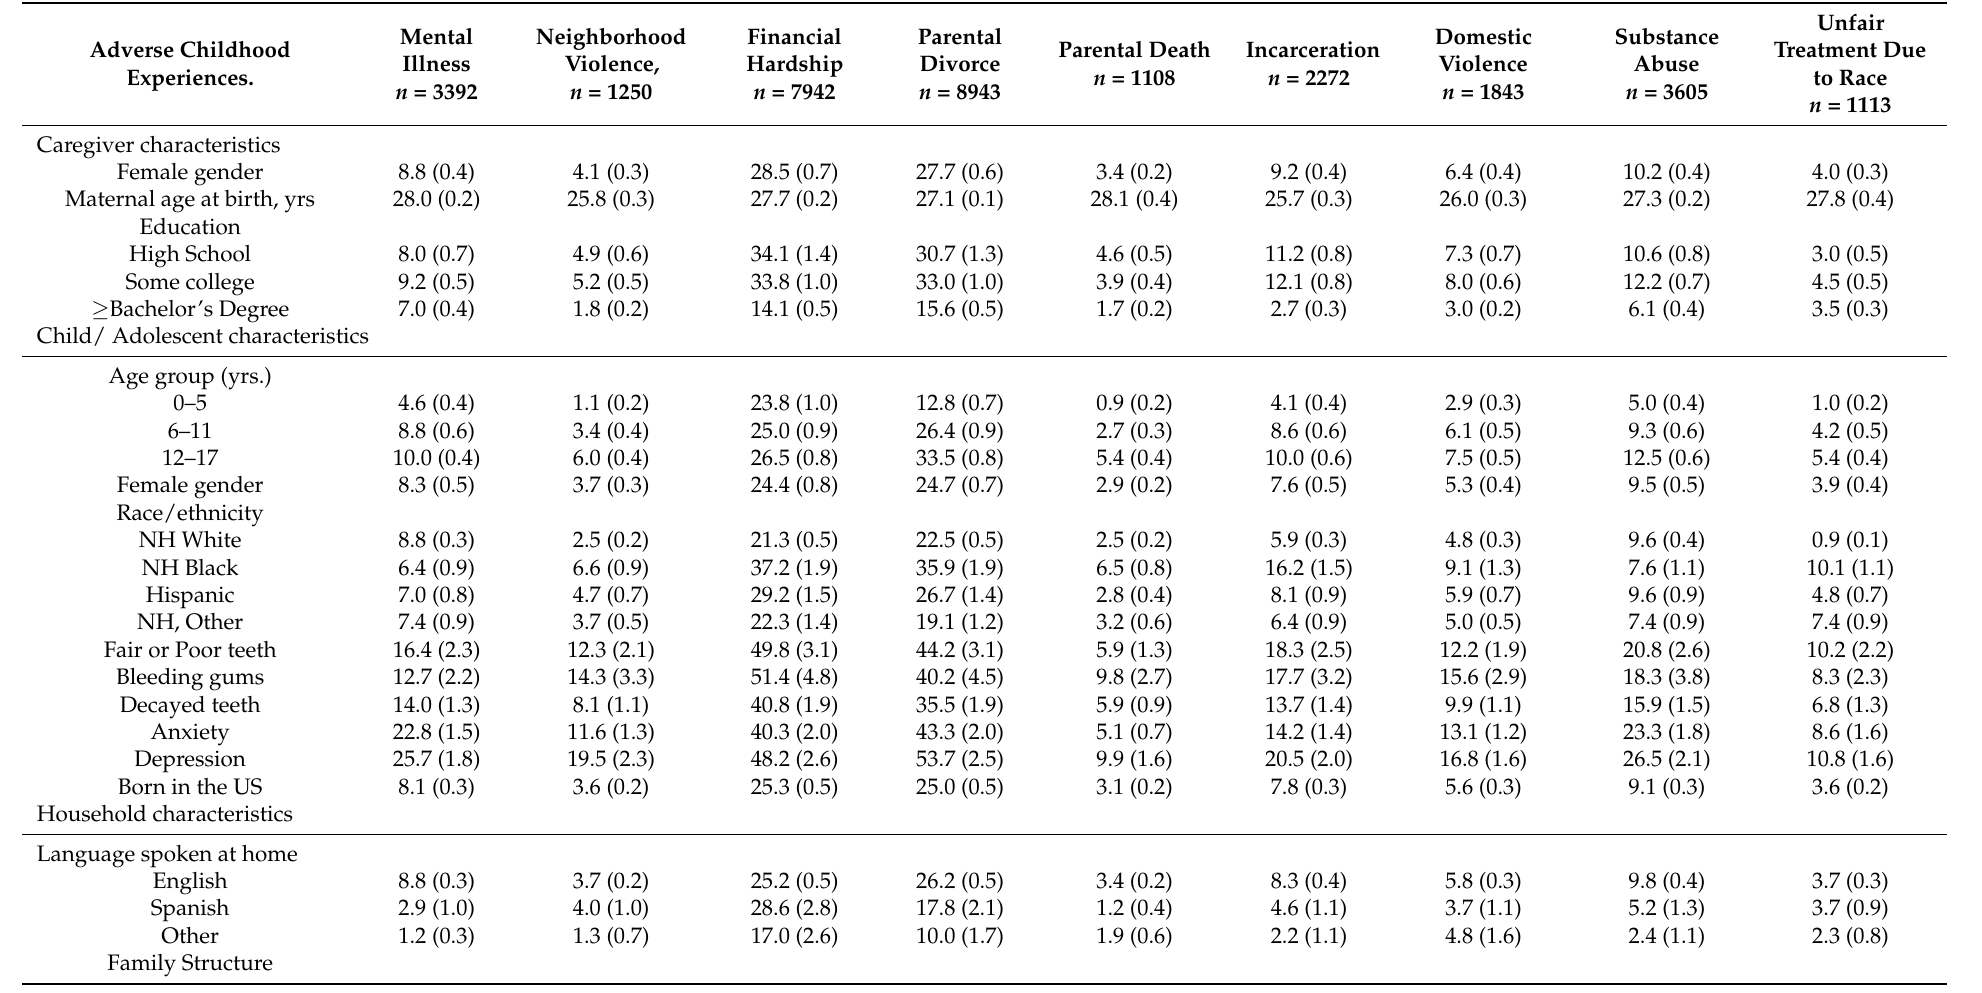
Table A1. Distribution (row percent (SE)) of selected socio-demographic factors according to selected ACEs measures, National survey of Children’s Health 2016 ( n = 41,294).